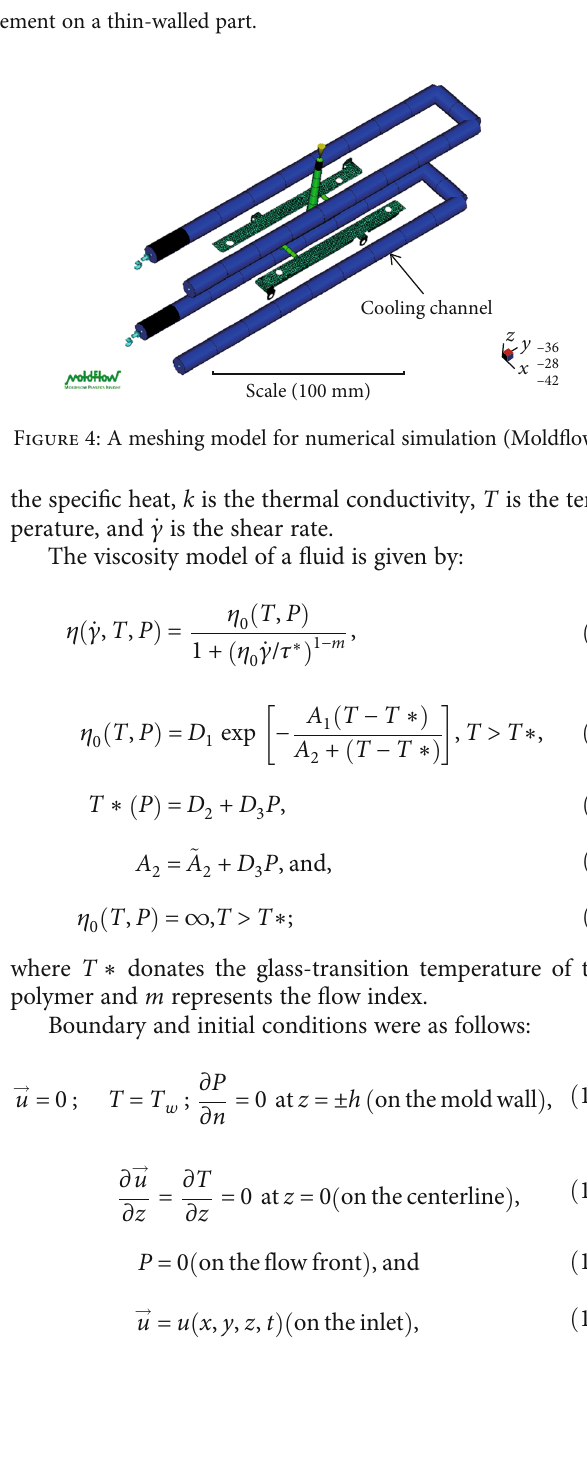
Figure 3: The warpage measurement on a thin-walled part.